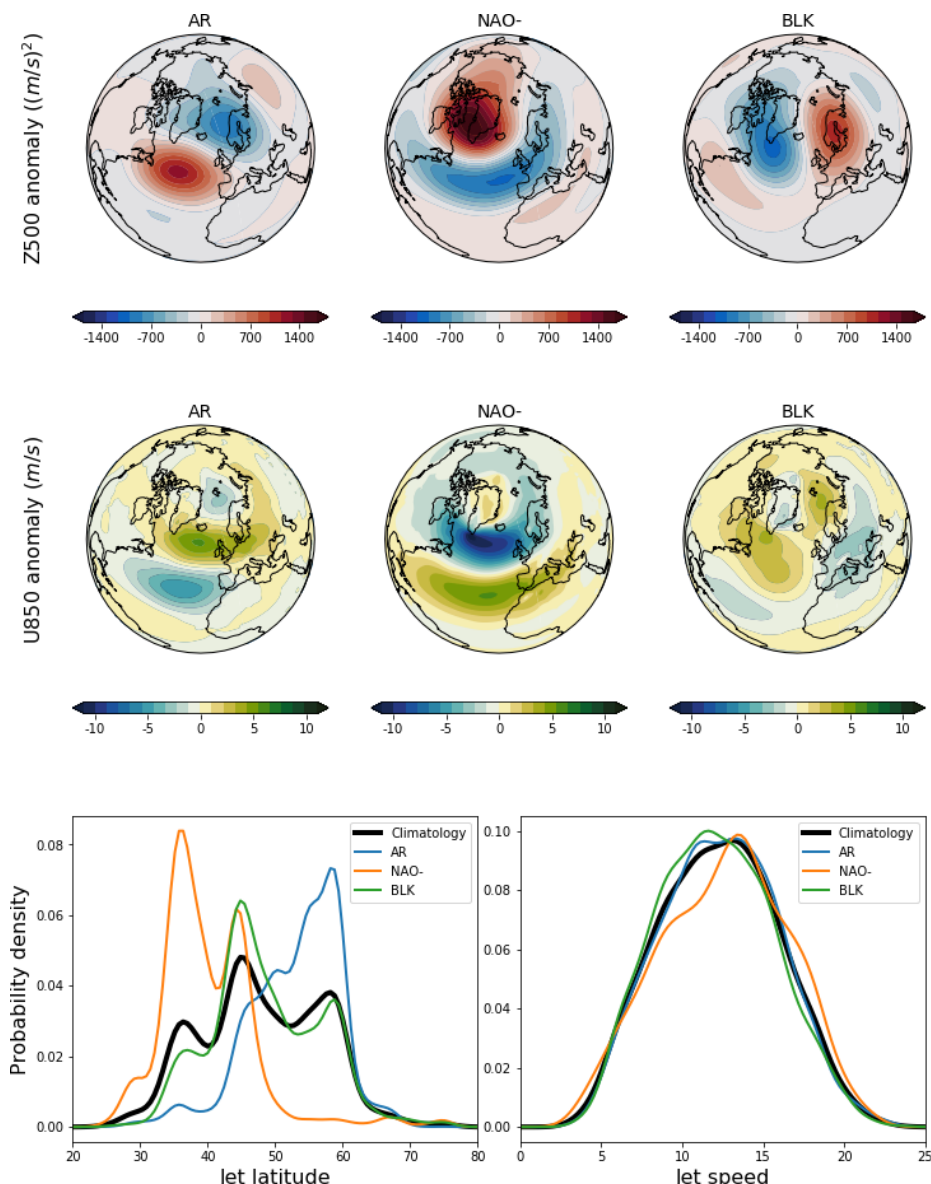
Figure 4. Regime composites for three geopotential-jet regimes in ERA20C. Top: 500hPa geopotential height anomalies. Middle: 850hPa zonal wind speed anomalies. Bottom left: distribution of jet latitude. Bottom right: distribution of jet speed.